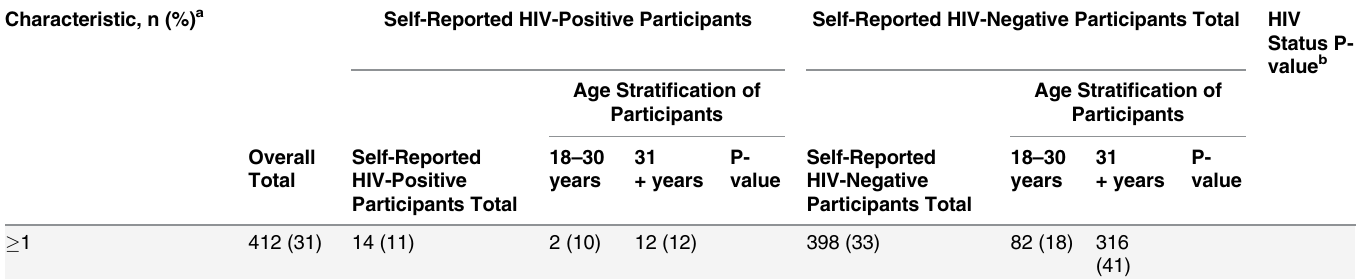
density of 0%; and 87% reported having sex partners who were also a part of their social networks. Compared with self-reported HIV-negative men, self-reported HIV-positive men were more likely to be older, self-identify as homosexual and gay, be married or living with a partner, have fewer sex partners, and have no female sex partners in the last six months. Among HIV- negative men, older men ( > 30 years) were more likely to report SDUI, have a sex partner of at least 2 age category difference, have smaller sexual network size, and have a female partner in the last six months compared with younger men (18 – 30 years). Among HIV-positive men, older men were more likely to have a smaller sexual network size compared with younger men. Over three-quarters of the sex partners of community-recruited participants were male, 18% female, and 4% transgender (Table 2). Sex partners of HIV-positive participants were more likely to be male and less likely to be female than partners of HIV-negative participants. Partners of HIV-positive participants were more likely to be HIV-positive and less likely to be HIV-negative than partners of HIV-negative participants. HIV-positive men reported not dis- closing their HIV status to 34% of their partners.